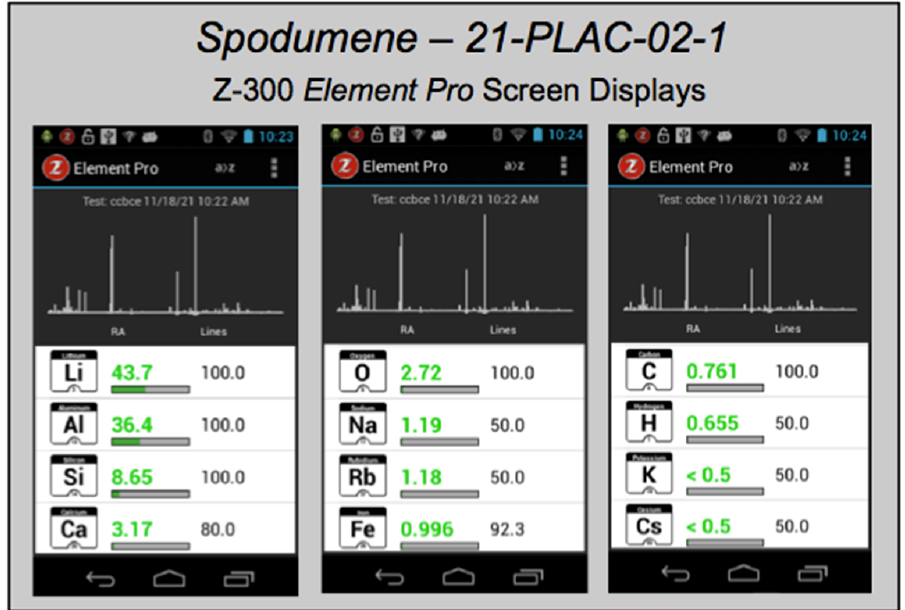
Figure 5. Z-300 screen shot sequence generated at the time of analysis showing the LIBS spectrum for spodumene in pegmatite outcrop 21-PLAC-02 on the Carolina Lithium Project prospect in Gaston County, N.C. and the 12 elements recognized with confidence in this sample—Li, Al, Si, Ca, O, Na, Rb, Fe, C, H, K, and Cs. The number in black text on the right-side column is the “likelihood” value, i.e., percentage of spectral lines in the on-board spectral library present in the LIBS spectrum, whereas the green number in the middle column is the “relative abundance” value. See text for